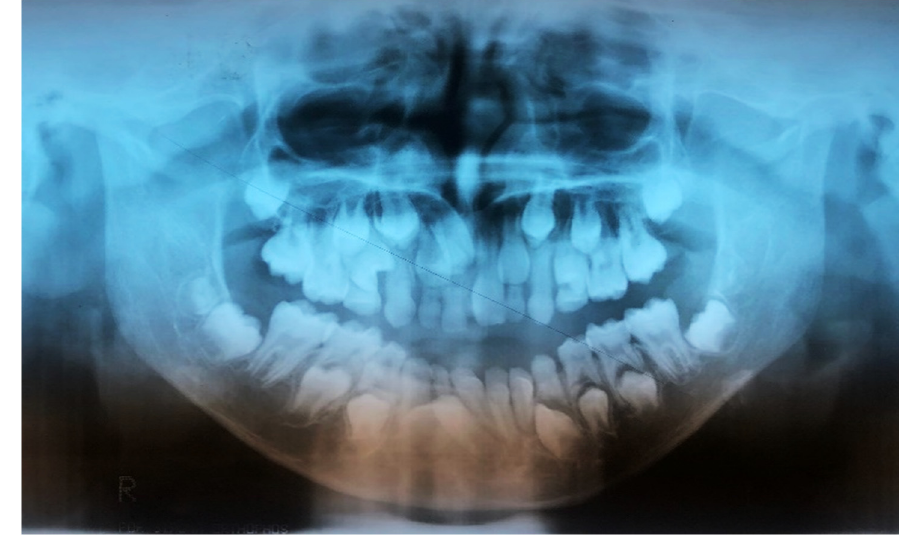
Figure 3. Initial 10/04/2008 orthopantomography (OPG) X-ray (10-year-old).